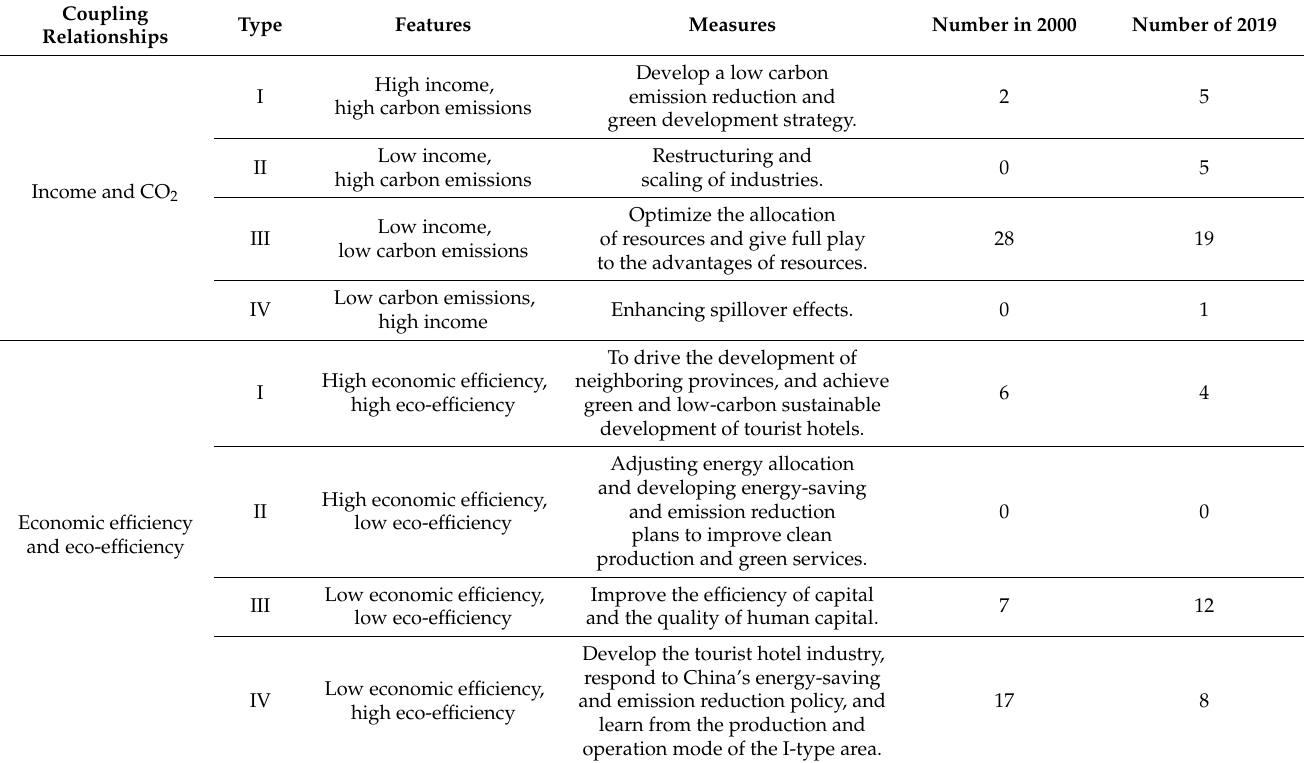
Table 3. Measures taken by different types of regions and changes in the number of